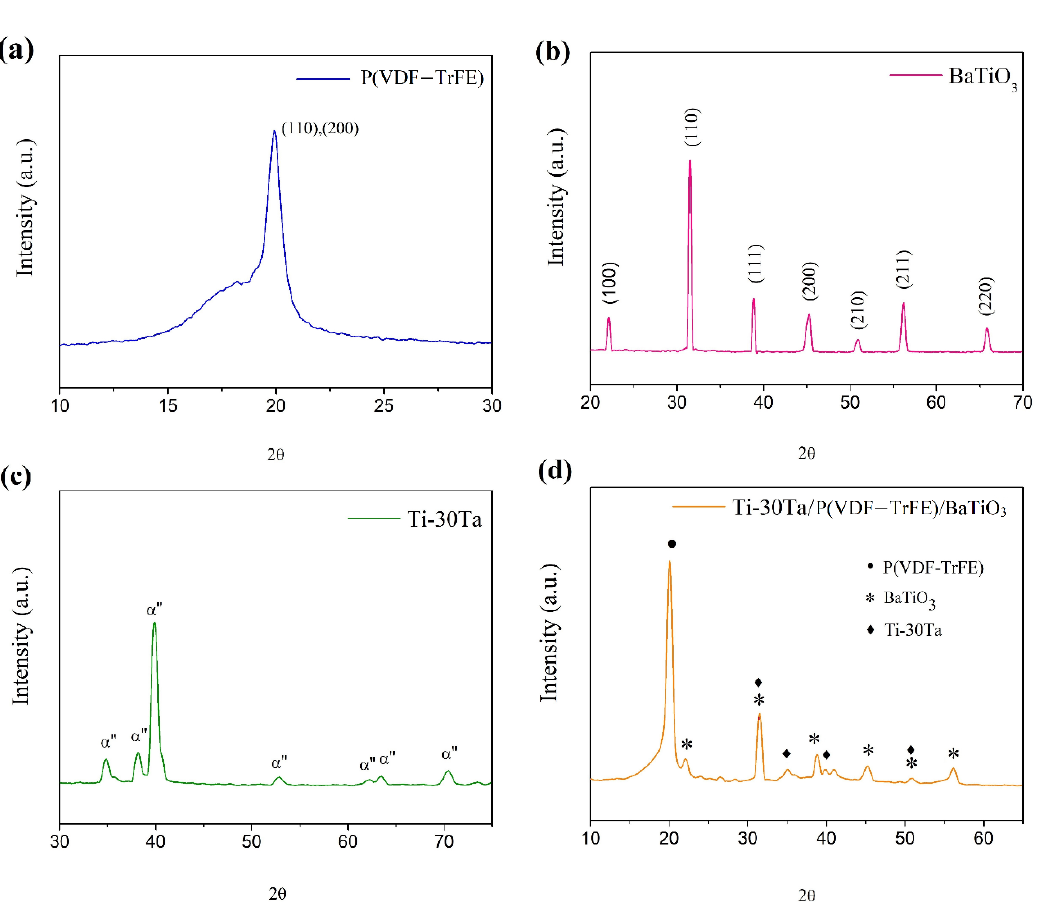
Figure 7. Diffractogram of ( a ) P(VDF-TrFE); ( b ) BaTiO 3 calcinated at 1380 °C; ( c ) Ti-30Ta alloy and ( d ) Ti-30Ta with polished surface treatment coated with P(VDF-TrFE)/BaTiO 3 .